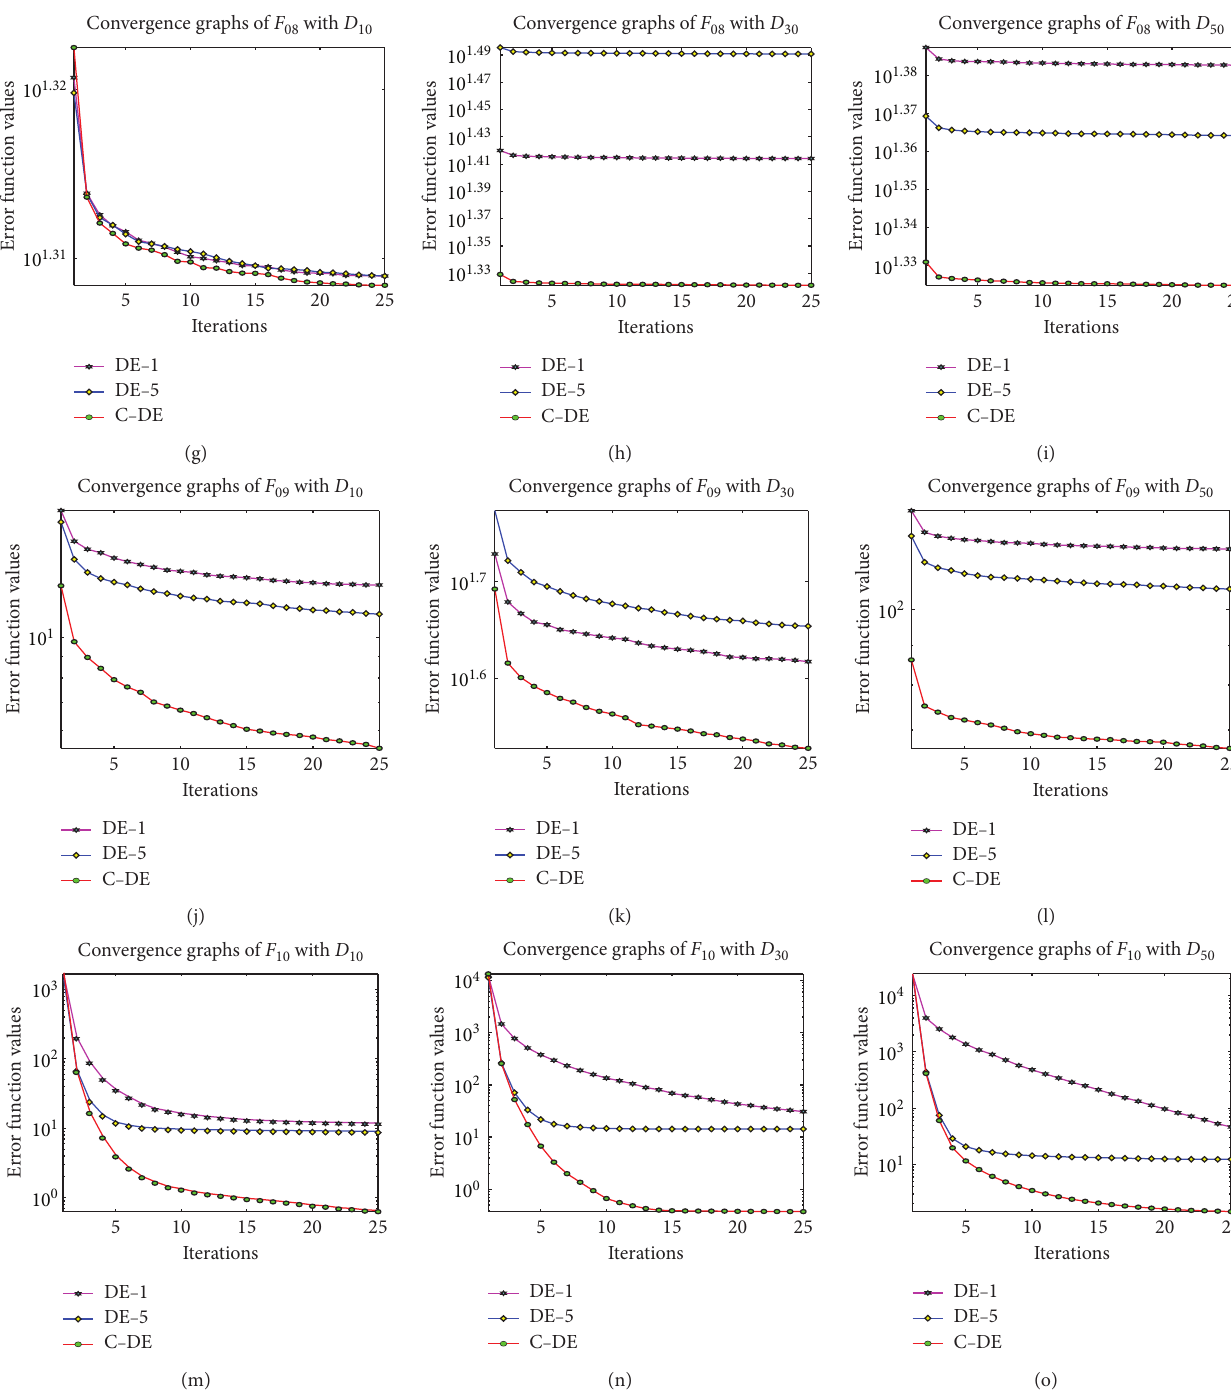
to F solved with DE-1, DE-5, and C-DE in n � 10, 30, and 50 6 10